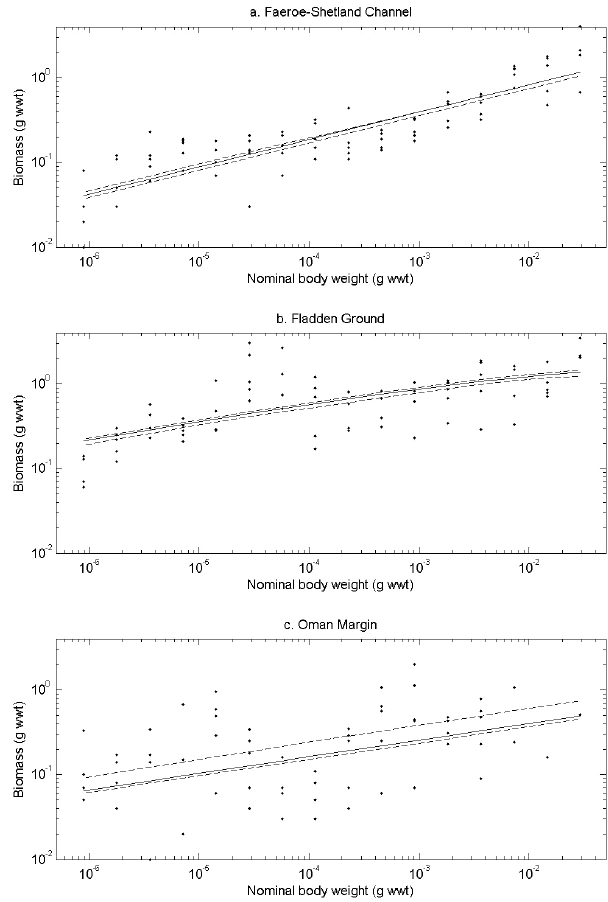
Figure 4. Optimized model biomass size spectra for each site. The observations contain five replicates per size class (closed circles). Dashed lines show the envelope for the 10 optimizations. The solid line corresponds to the optimization that resulted in the best fit to